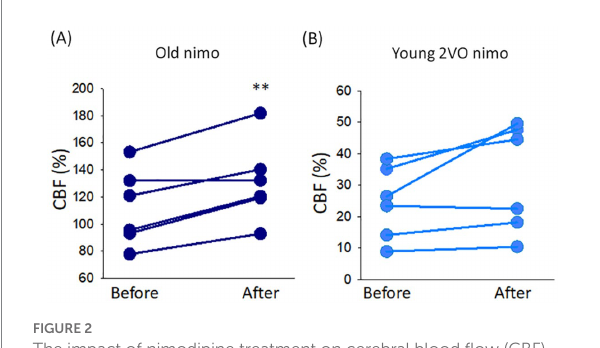
FIGURE 2 The impact of nimodipine treatment on cerebral blood flow (CBF).